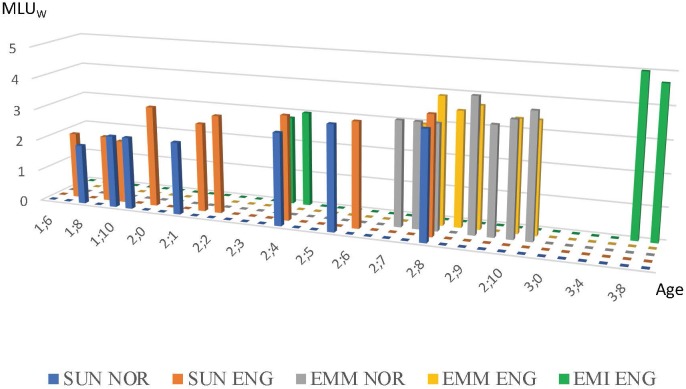
Overview of MLUW in both languages according to age for Emma, Emily and Sunniva.